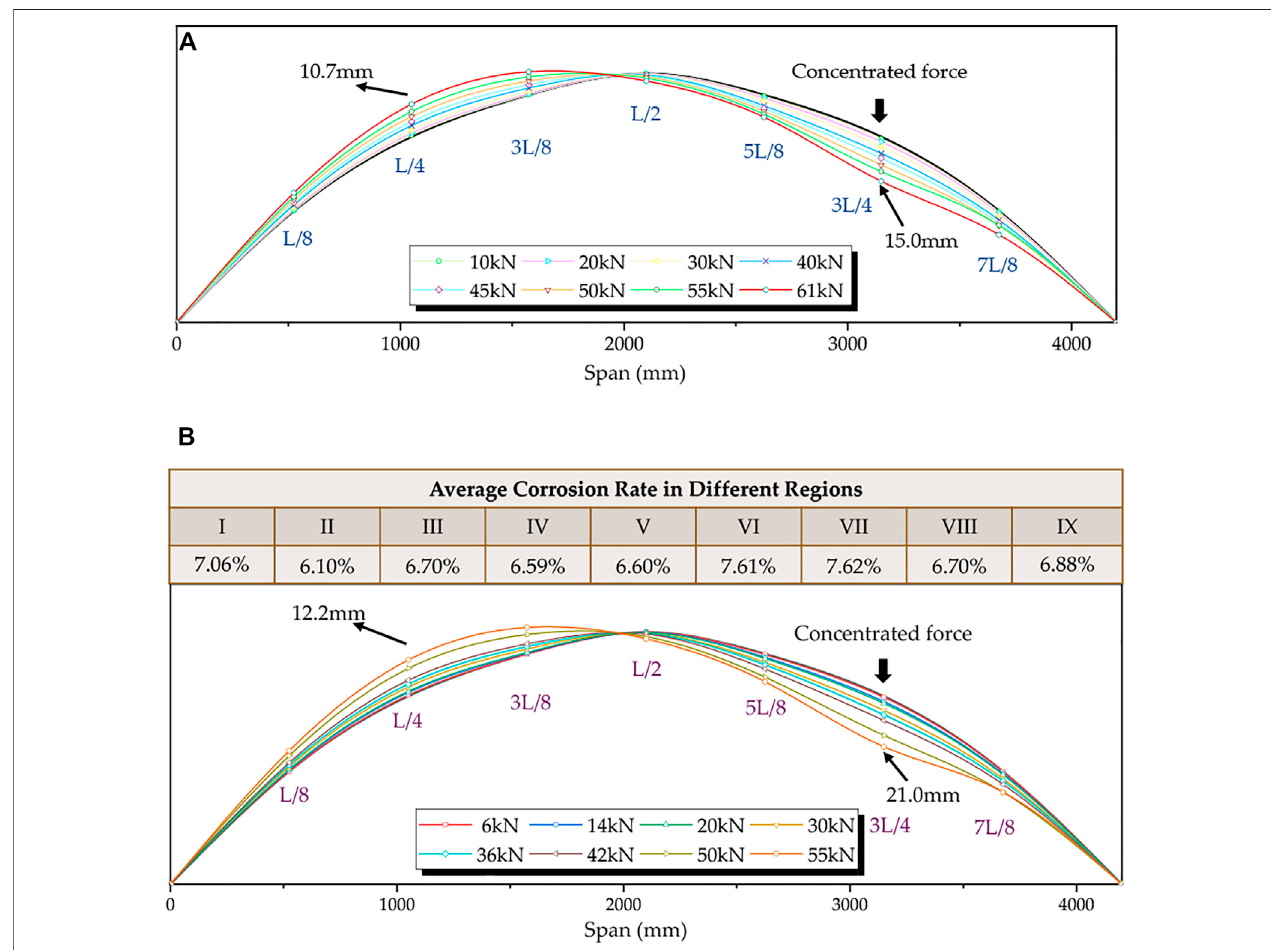
FIGURE 9 | Load-de fl ection curve of arch ribs: (A) arch 0# and (B) arch 1#.